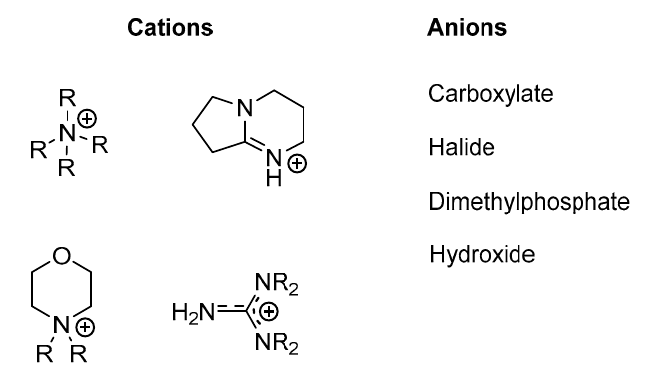
Figure 2. The general molecular structures of the electrolytes reviewed: ammonium, morpholinium, amindinium and guanidinium cations and the most commonly used anions.